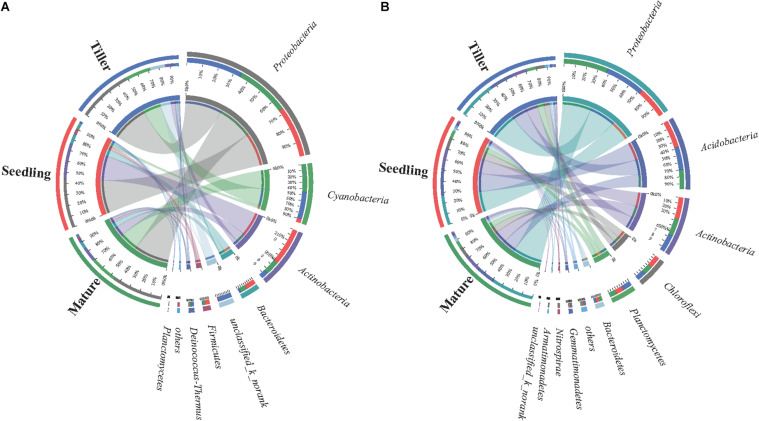
 Distribution of phyllosphere (A) and rhizosphere (B) bacterial communities for each sample at phylum level. The width of the bars from each phylum indicate the relative abundance of that phylum in the sample.